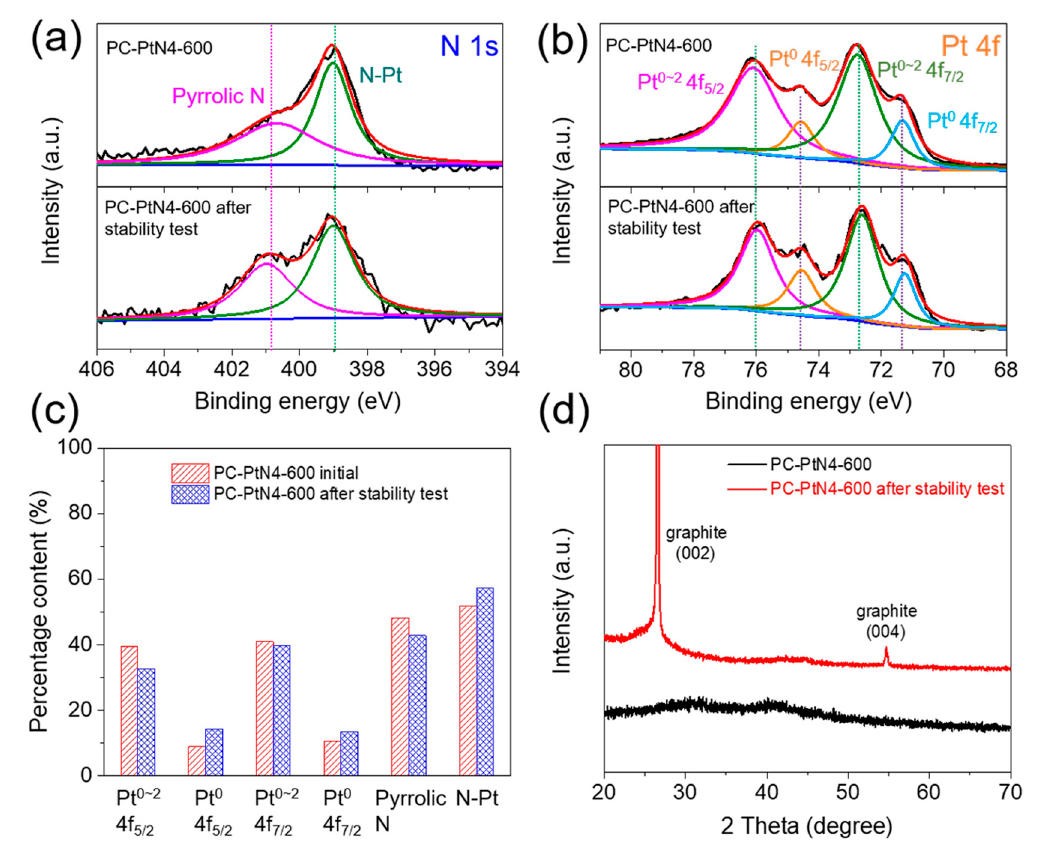
Figure 6. ( a ) N 1s XPS spectra, ( b ) Pt 4f XPS spectra and ( c ) Pt and N contents and ( d ) XRD patterns of PC-PtN4-600 before and after accelerated degradation test (ADT).